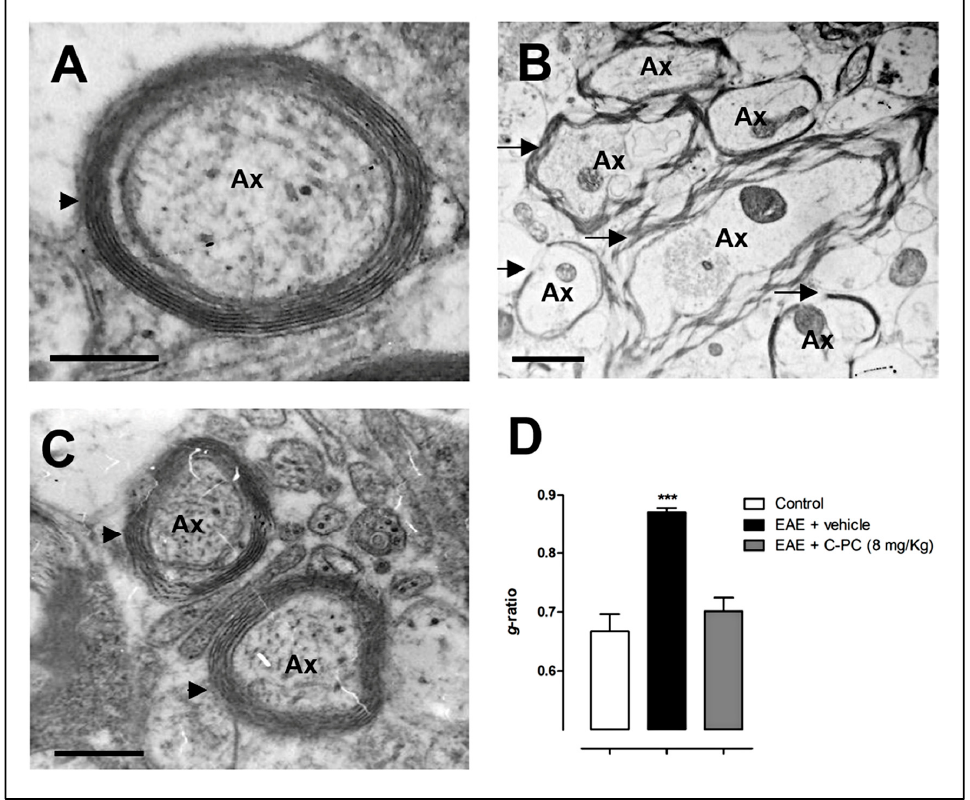
Figure 2. C-PC-induced remyelination in the MOG 35–55 -induced EAE model in C57BL/6 mice. Panels show representative electron microscopy images of spinal cord samples from ( A ) non-diseased; ( B ) EAE-vehicle treated and ( C ) EAE-C-PC 8 mg/Kg treated animals; ( D ) g -ratio = [axon diameter/(myelin + axon) diameter] (mean ± S.E.M. *** p < 0.001 vs. control group, ANOVA + Newman-Keuls tests using GraphPad Prism Software). C-PC at 8 mg/Kg or the vehicle were administered i.p. daily at disease onset (between days 11 and 12 post-immunization) for 15 days ( n = 4–7 each group). Control (non-immunized) animals received phosphate buffered saline instead of encephalitogen. Spinal cord samples were taken at the end of the study period (day 29 post-immunization). Arrowheads or arrows indicate normal myelin structure/thickness or myelin damage/loss, respectively. Ax: axon. Bar = 200 nm.